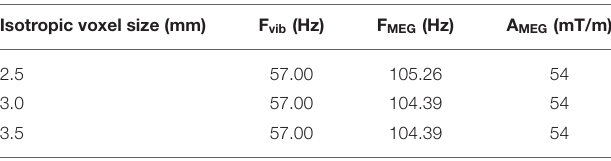
TABLE 1 | Motion encoding parameters used for MRE acquisitions on the phantom for different voxel